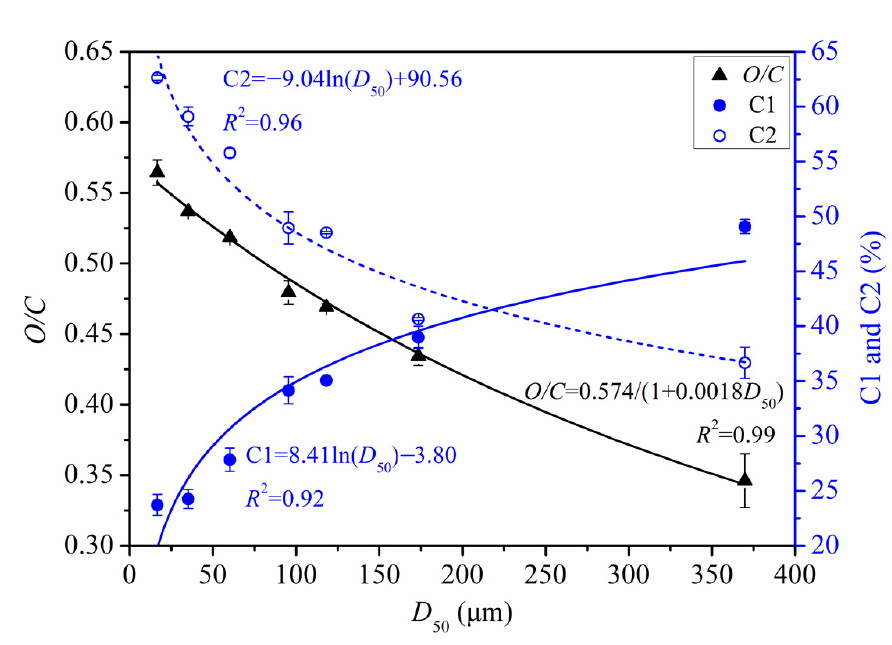
Figure 9. Quantitative relationship between surface elemental properties and D 50 of PIDF.